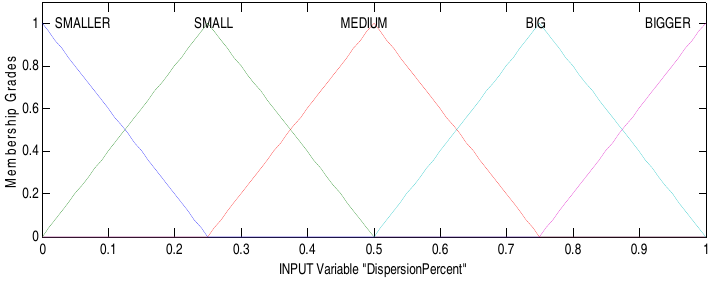
Figure 7. Input variable of DPFFWA-I (DispersionPercent).